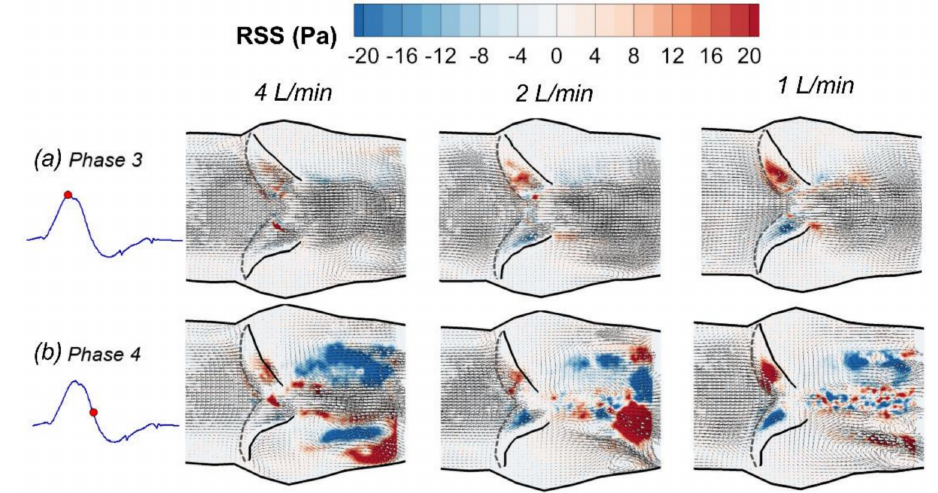
Figure 10. Reynolds shear stress under reduced cardiac outputs ( a ) peak systole (phase 3); ( b ) after peak systole (phase